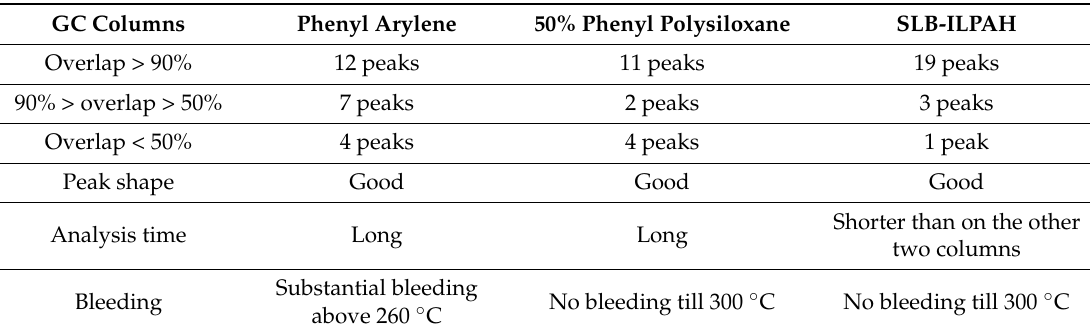
Table 3. Chromatographic characteristics of the three columns: DB-5ms, SLB PAHms and SLB-ILPAH. GC